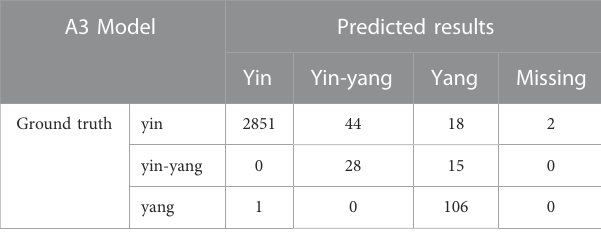
TABLE 5 Cell classi fi cation performance in the test dataset.